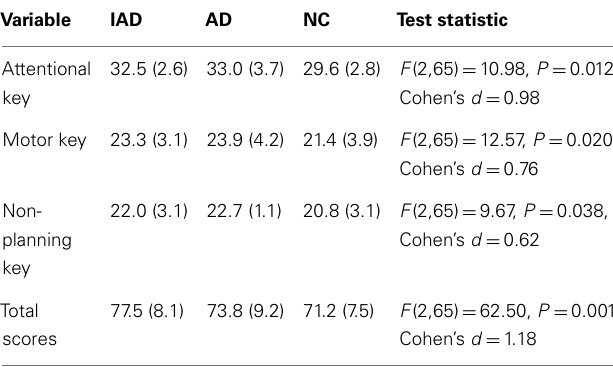
Table 2 | BIS-11 scores [mean (SD)] in IAD group ( n = 22),AD group ( n = 22), and NC group ( n = 22) .